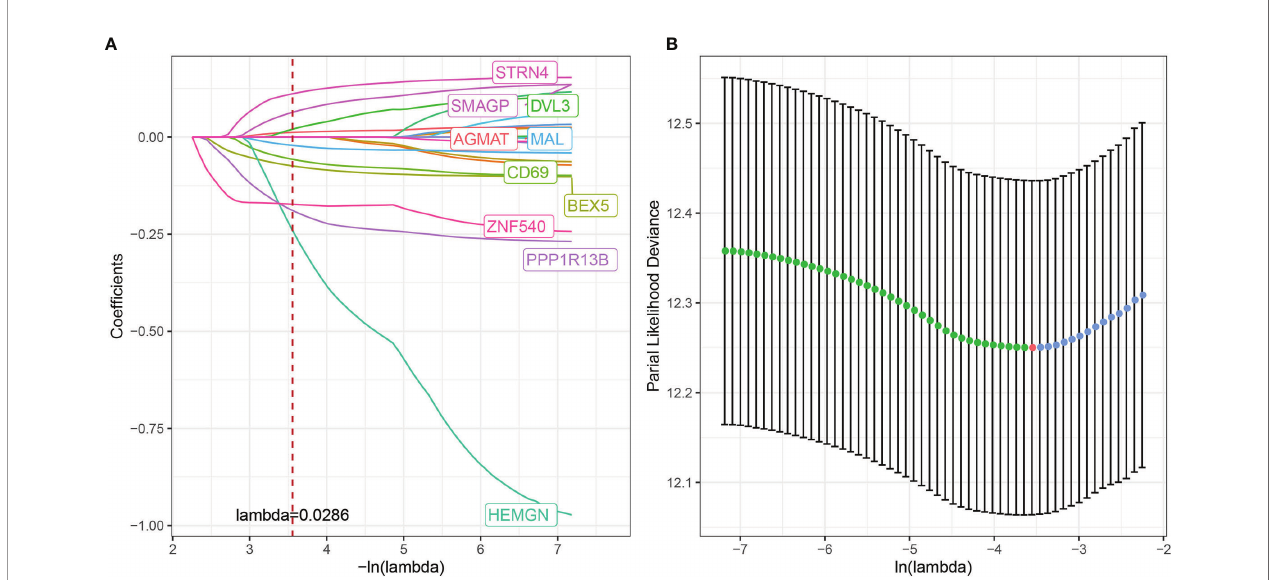
FIGURE 9 | Multivariate risk analysis using the training set for construction of a prognostic risk model based on CD8 + T cell-associated genes. (A) Trajectory of each independent variable, where the horizontal axis represents the log value of the independent variable, lambda, and the vertical axis represents the coef fi cient of the independent variable. (B) Con fi dence interval under each